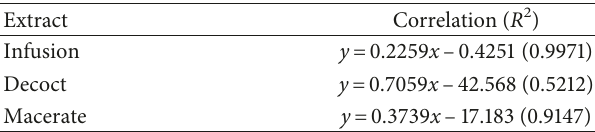
Table 3: Correlations between total phenolic content and flavo- noids content of extracts obtained from different aerial parts of Rudbeckia triloba